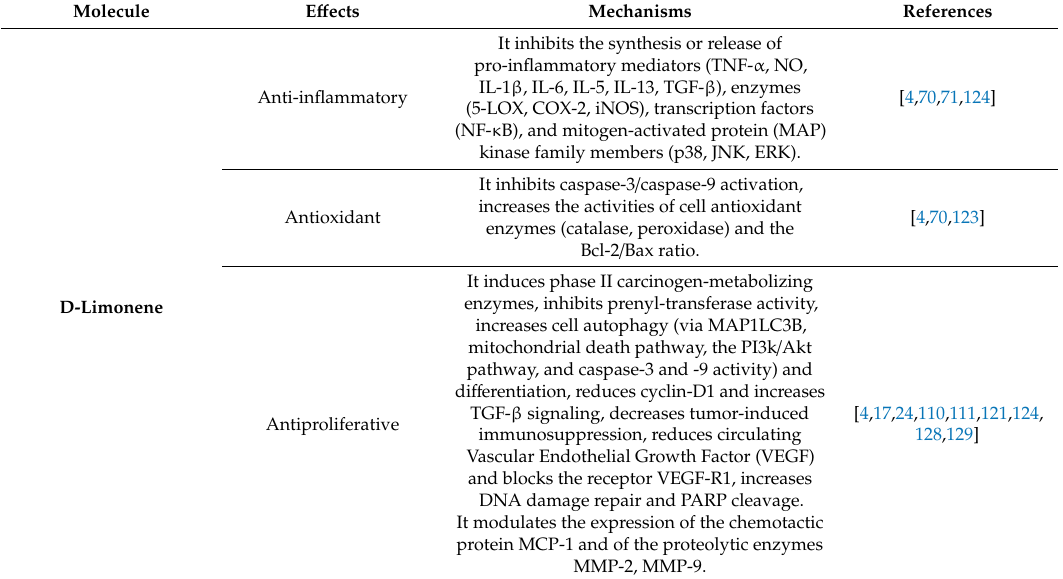
Table 9. Summary of preclinical evidence relative to biological activities of the five most common forest VOCs